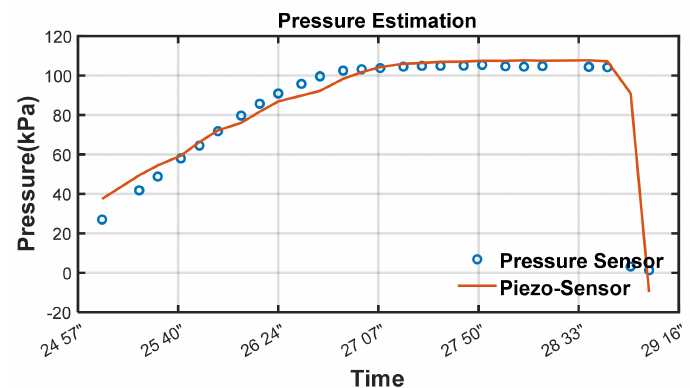
Figure 12. Result of pressure estimation using EMI in the non-damaged state (test 1).